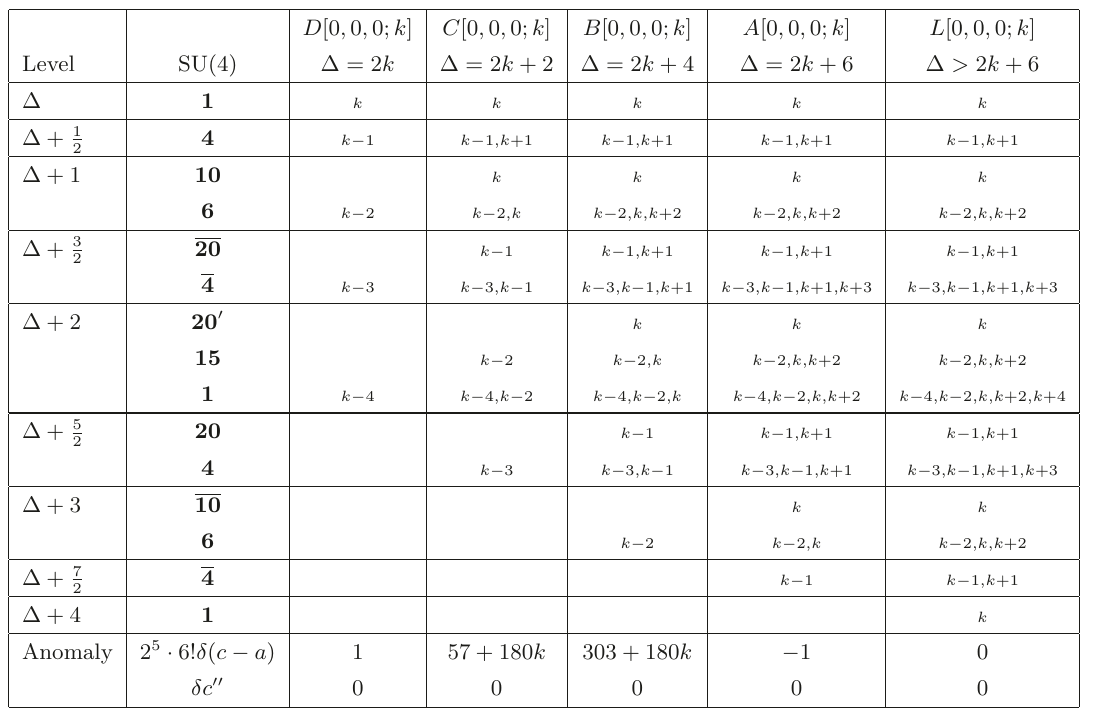
Table 2 . The N = (1 , 0) multiplets with maximum spin two, and corresponding holographic Weyl anomaly coefficients δ ( c − a ) and δc ′′ . Here k is the SU(2) R Dynkin label (with spin = k/ 2). The shortening conditions correspond to those of (2.12), while the last column is the maximum spin-two long